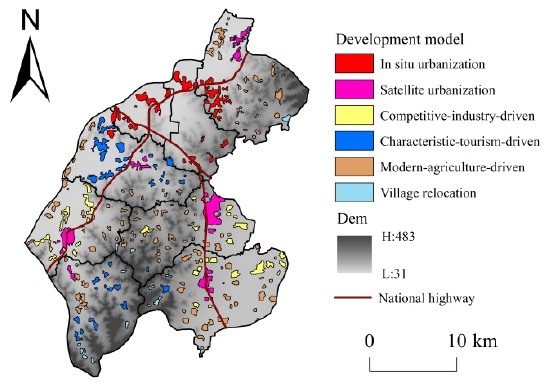
Figure 9. The development model for rural settlements in Pingyin